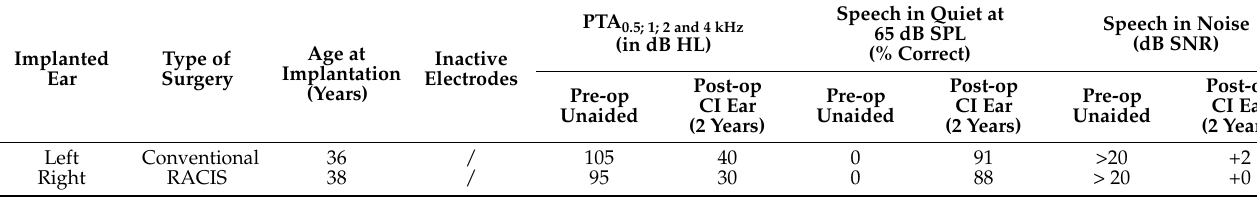
Table 2. The subject’s audiological outcomes.